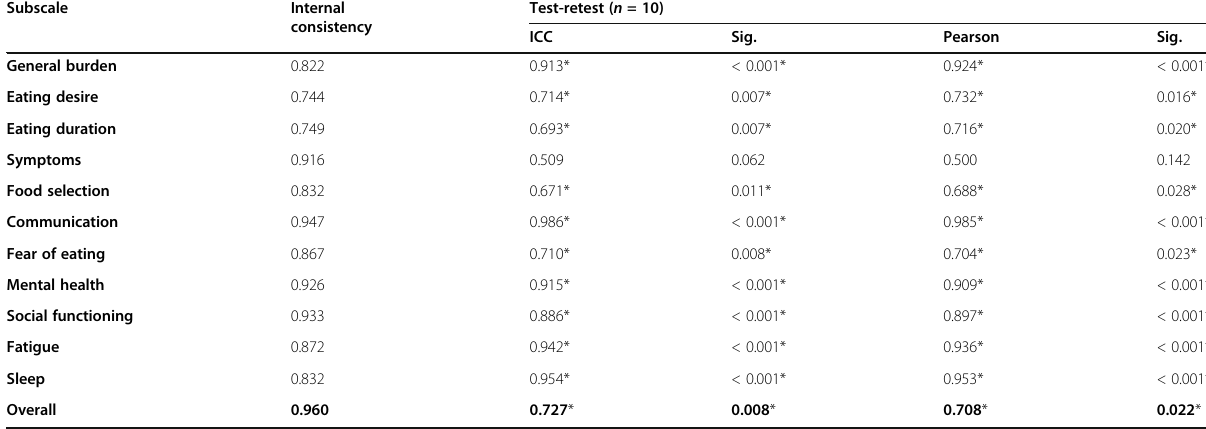
Table 6 Reliability of ASWAL-QOL ( n =